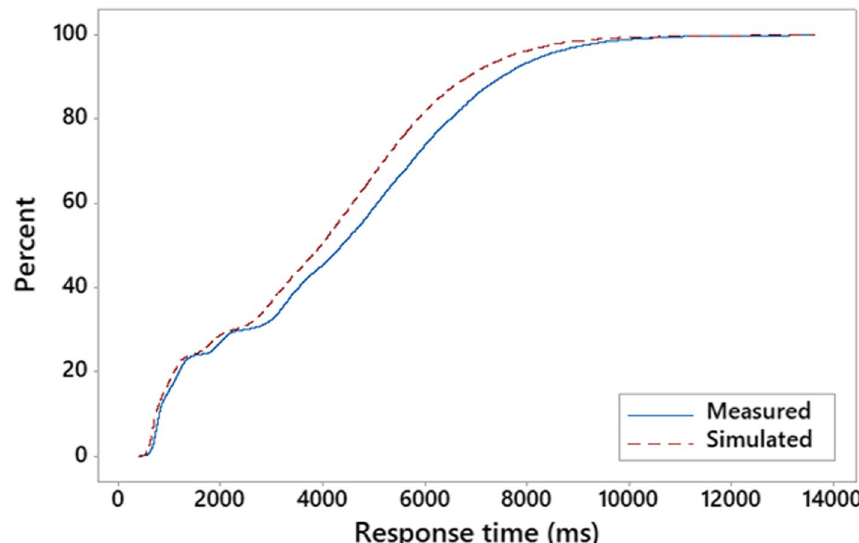
Fig. 10 ECDF plot of measured and simulated values of response time for rapid growth validation scenario, video service, large instance